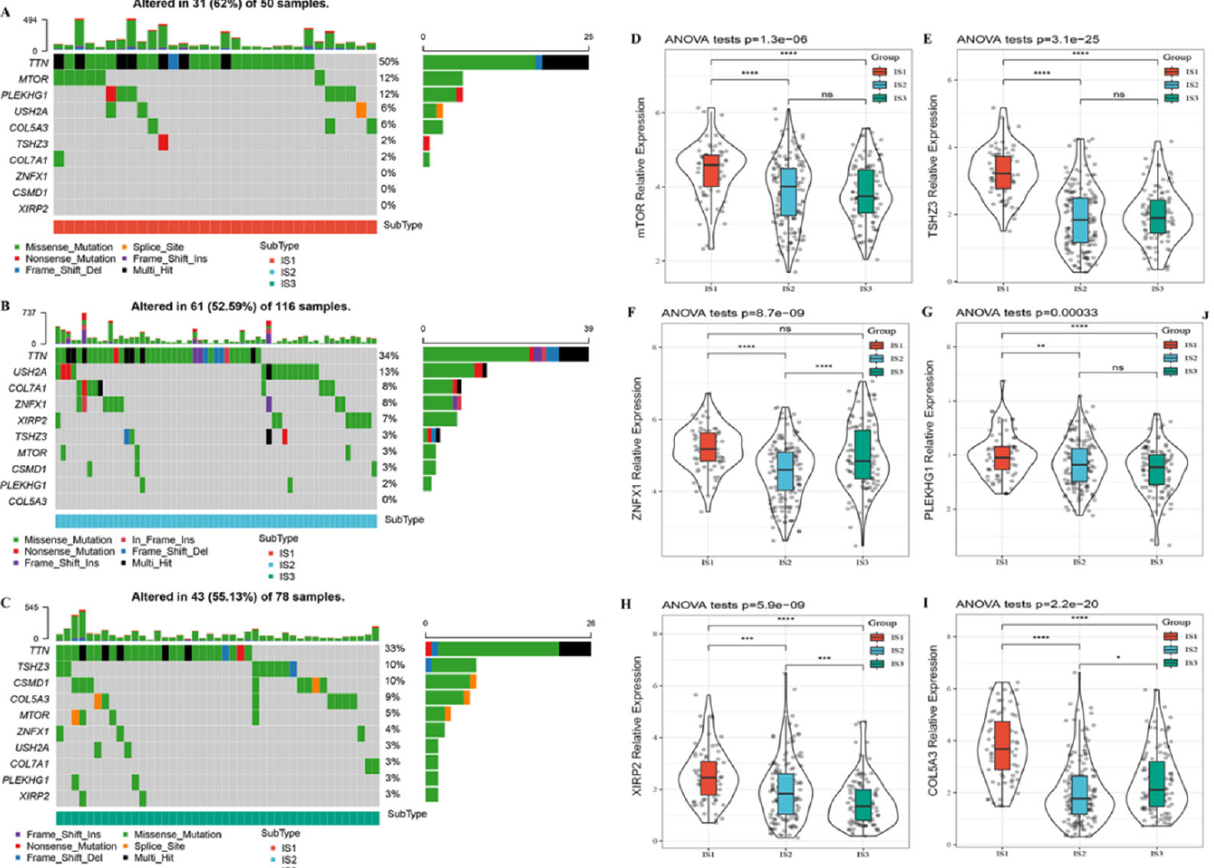
Figure 2. Hub mutation gene features in different immune subtypes. A–C . Top 10 mutation gene maps for the three immune subtypes: IS1 ( A ), IS2 ( B ), and IS3 ( C ). D–I . Differential expression of mutation genes among three immune subtypes: mTOR ( D ), TSHZ3 ( E ), ZNFX1 ( F ), PLEKHG1 ( G ), XIRP2 ( H ), and COL5A3 ( I ). * p < 0.05; ** p < 0.01; *** p < 0.001; **** p < 0.0001, and ns, no significance.